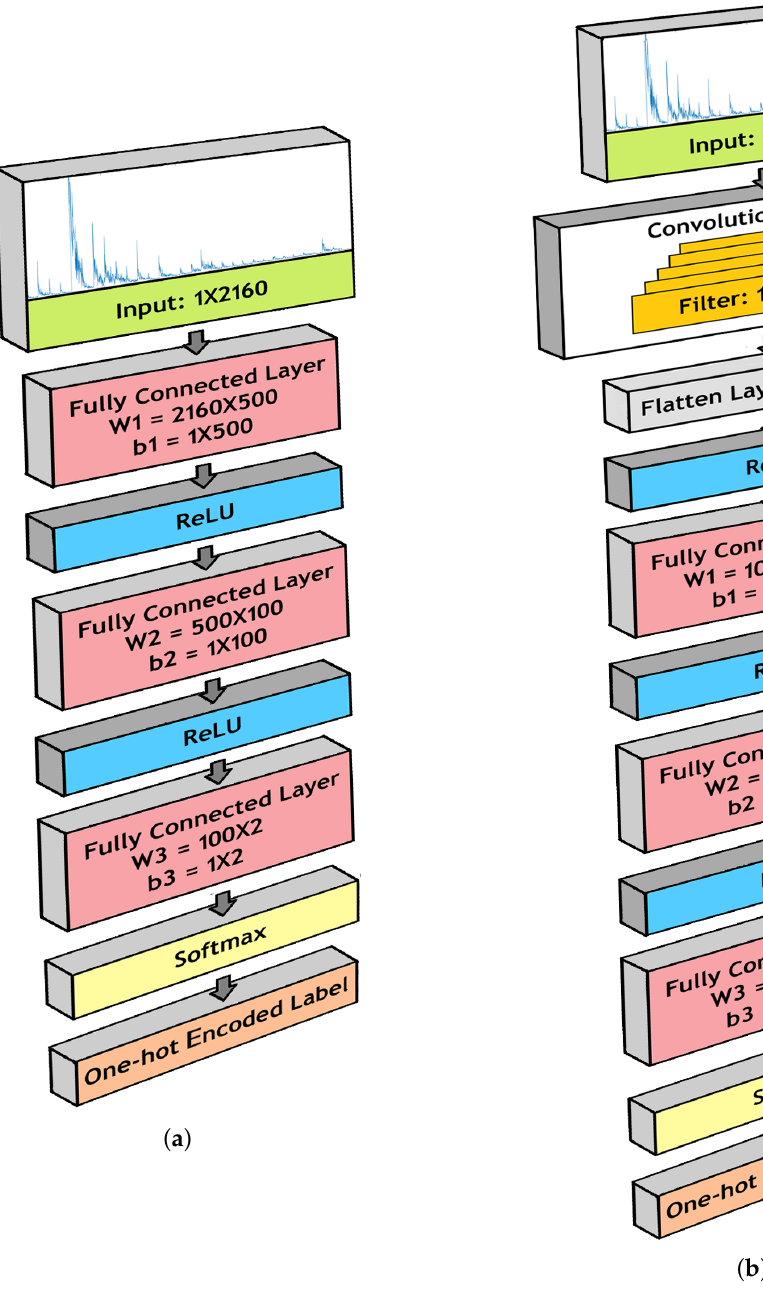
Figure 4. Model for binary classification using ( a ) Fully Connected Neural Network (FCNN) architecture and ( b ) a Convolutional Neural Network (CNN)